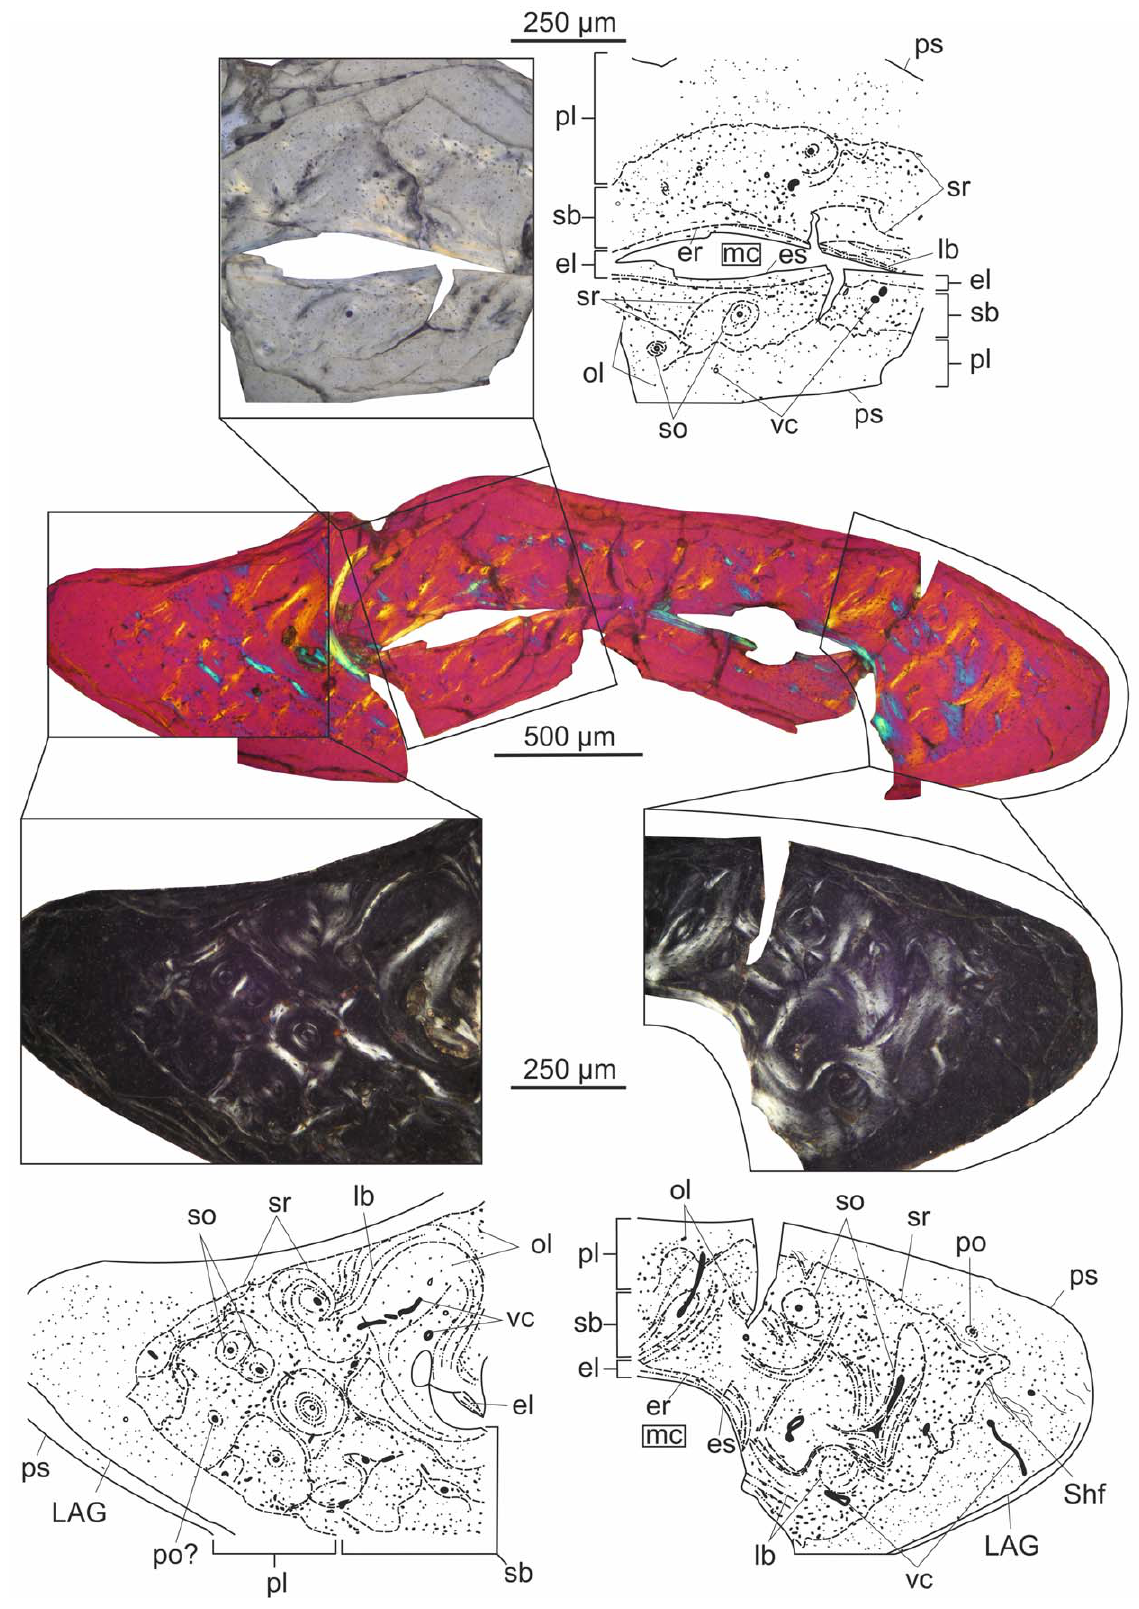
Figure 4. Histology of the III. phalanx of the wingfinger in MTM 2008.33.1. under normal polarized light and crossed nicols. The medullary cavity is lined by a narrow layer of endosteal bone. The middle cortical layer is composed of loose Haversian bone. The outermost, primary layer is formed of sparsely vascularized fibrolamellar bone with one peripheral LAG.